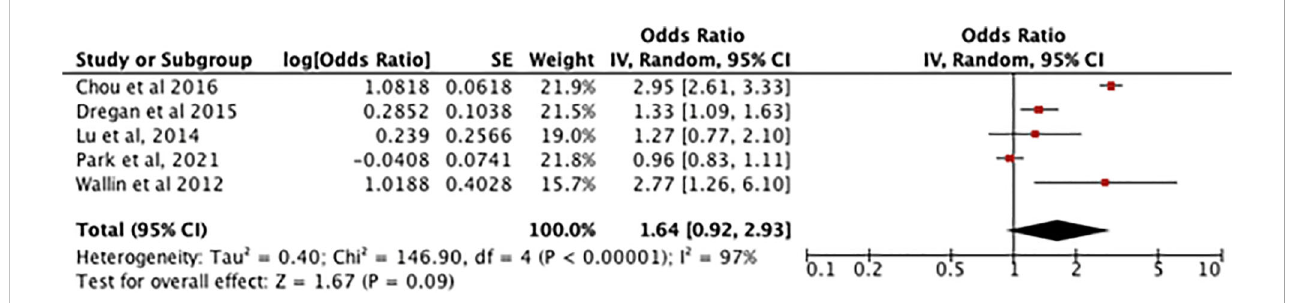
FIGURE 4 Forest plot showing the results of meta-analysis investigating the relationship between RA and risk of dementia. Positive odds ratio values indicate that dementia is more prevalent in rheumatoid arthritis patients, with the P value showing its statistical signi fi cance. (8, 11 –